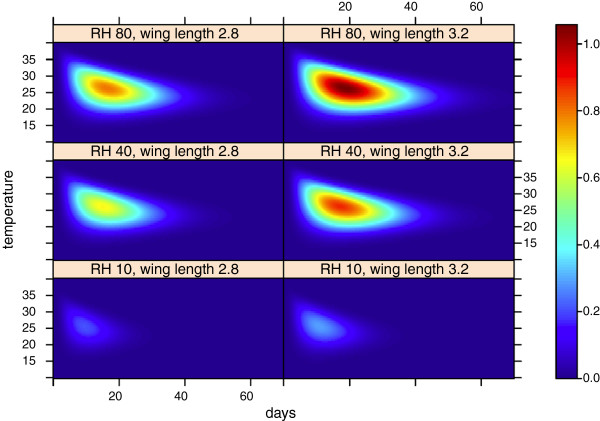
Percentage of 1000 mosquitoes that are infectious after x days. The y-axis represents temperature in degrees centigrade. The model is integrated at two mosquito sizes (2.8 and 3.2 mm for wing length) and three relative humidity values.